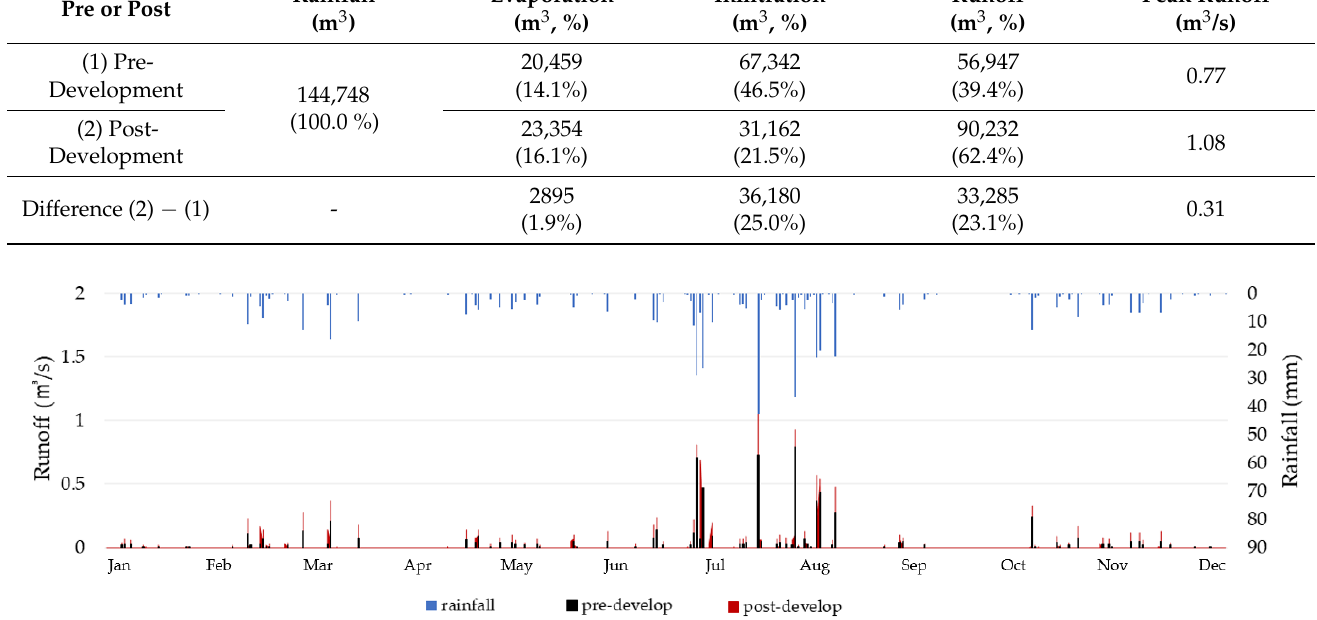
Figure 8. Rainfall and runoff of pre- and post-development research site.